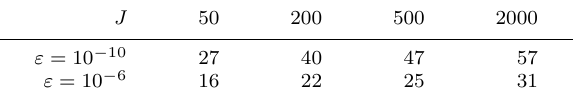
Table 7. Number of iterations for Neumann problem in quasi-circle.